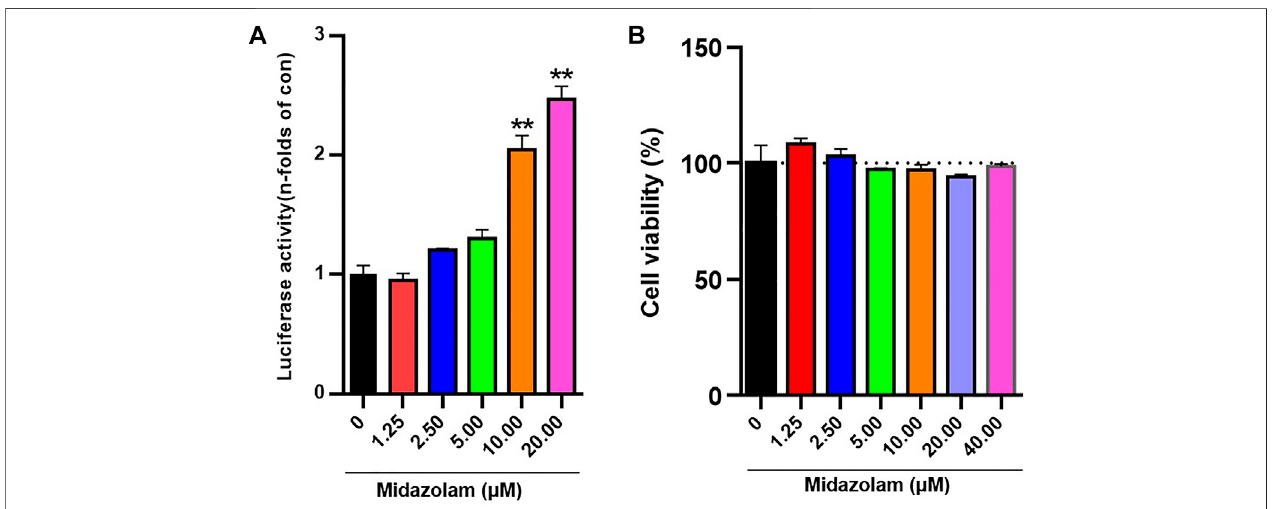
FIGURE 2 | Effects of different concentrations of midazolam on Nrf2 activation and cell viability. (A) Luciferase report assay analyzed the activity of 293T-Nrf2-luc cells after 24 h treatment with different concentrations of midazolam (0, 1.25, 2.5, 5, 10, 20 μ M); (B) CCK-8 assay analyzed the effect of different concentrations of midazolam (0, 1.25, 2.5, 5, 10, 20, 40 μ M) on 293T-Nrf2-luc cells viability. The results were shown as mean ± S.D. ** p < 0.01 vs. the control group.